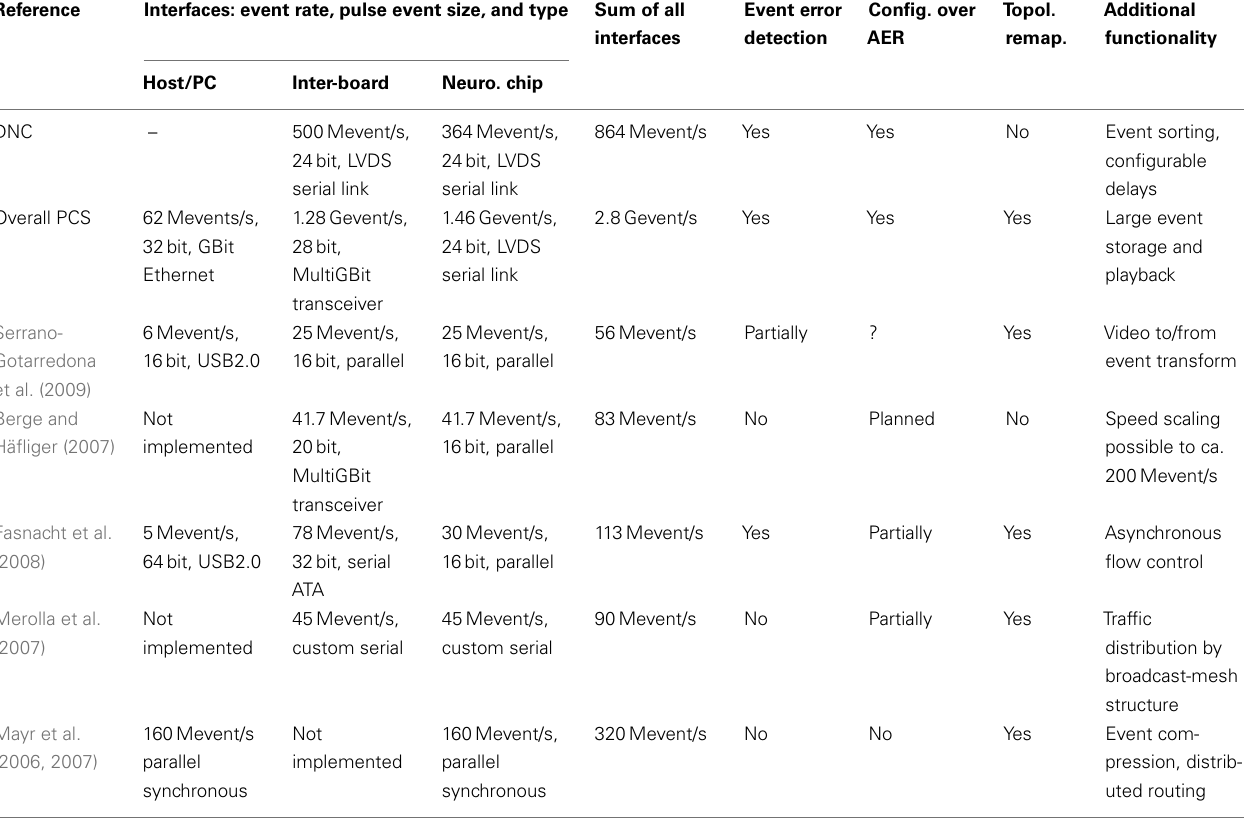
Table 1 | Characteristics of the presented DNC, overall PCS, and comparable implementations.